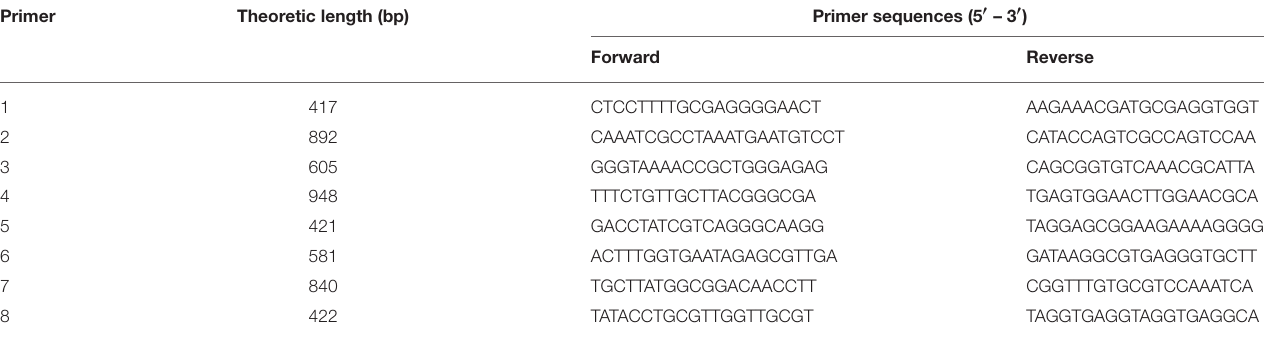
TABLE 4 | Primers for verification of DSLV1